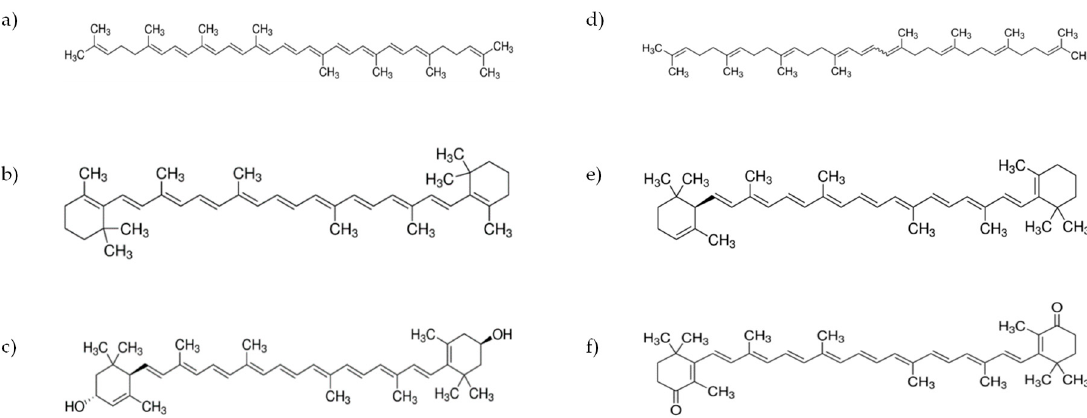
Figure 2. Chemical structure of various carotenoids that are present in tomato and tomato by-products; ( a ) Lycopene, ( b ) β -carotene, ( c ) lutein, ( d ) phytoene, ( e ) α -carotene, ( f ) canthaxanthin.